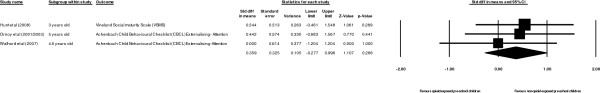
Forrest plots comparing behaviour in opiod and non-opiod exposure.